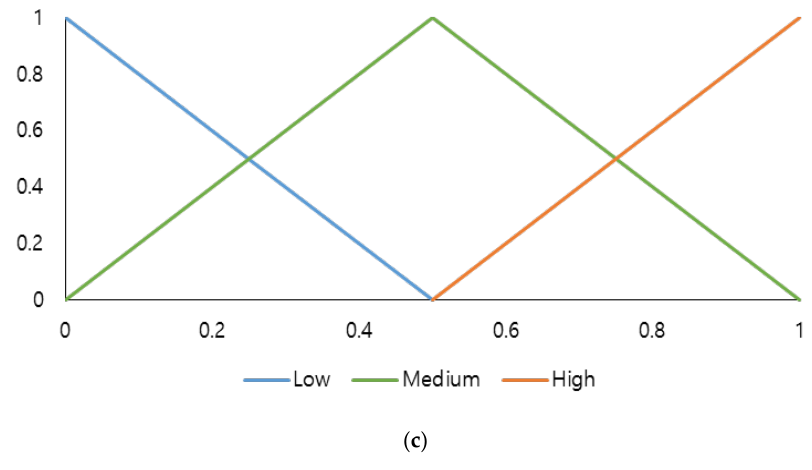
Figure 3. Membership functions. Input membership function ( a ) for pedestrians; ( b ) for non-pedestrian features. ( c ) Output membership function.